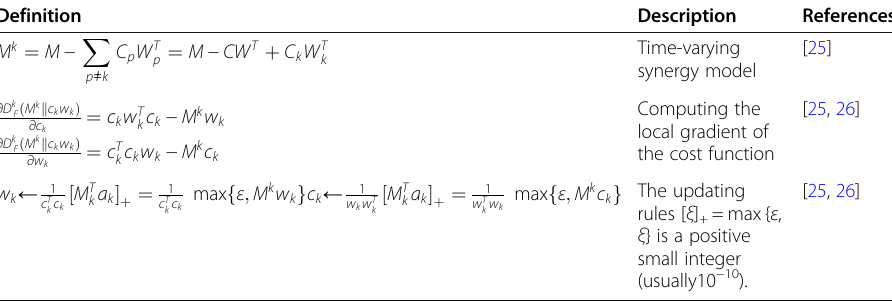
Table 1 Mathematical description of the HALS algorithm